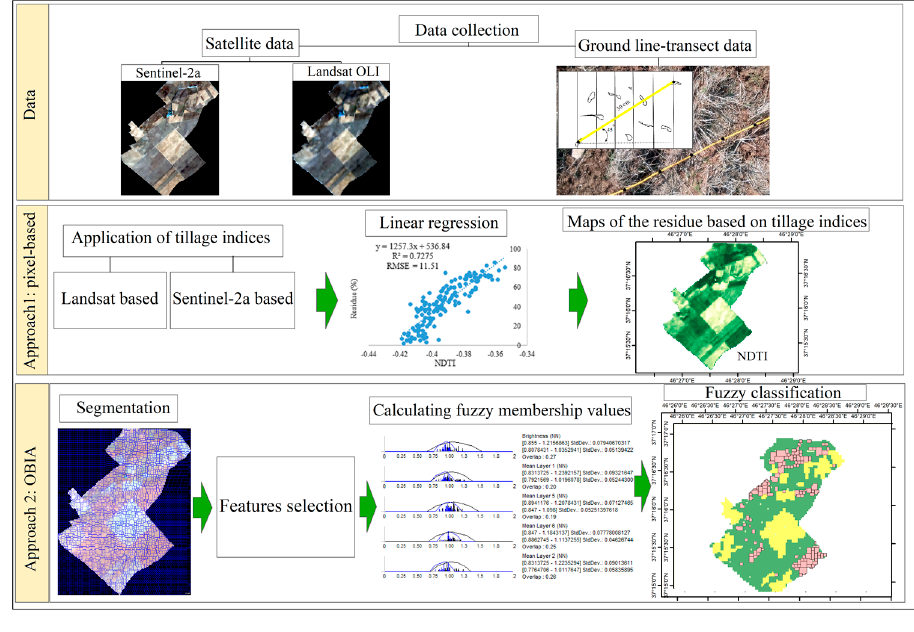
Figure 2. Overview of the methodology. Table 1. Specifications of Sentinel-2A and Landsat-8 satellite images (in bold: bands used in this study).